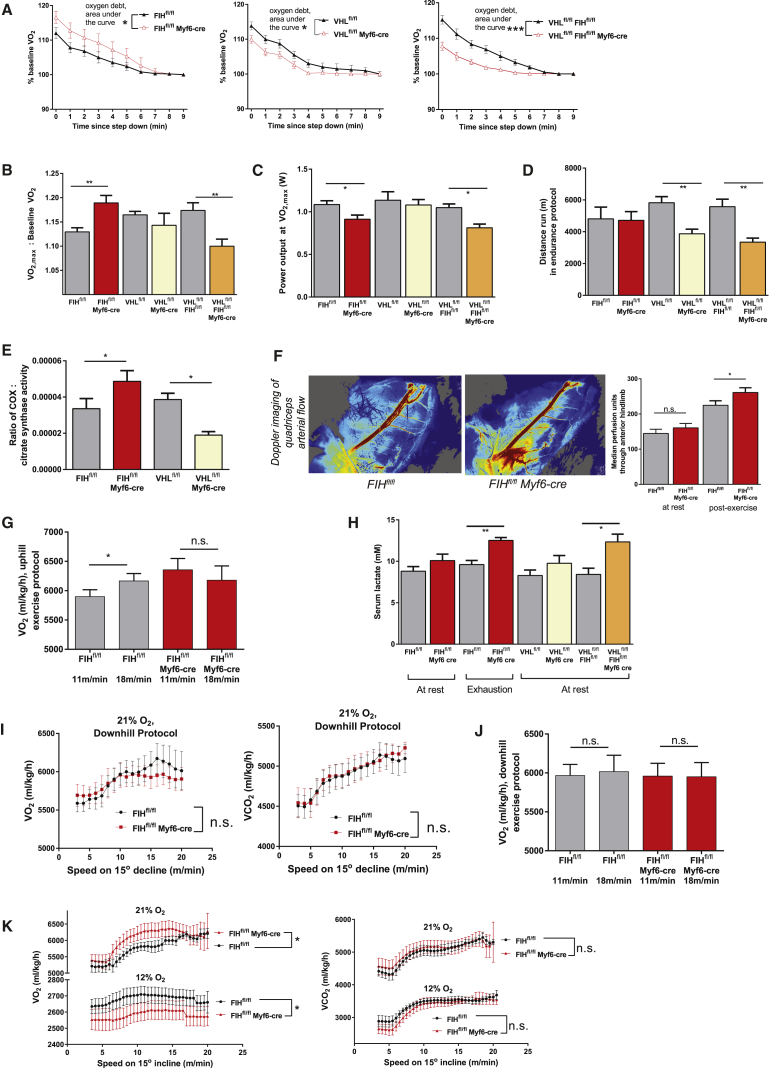
Effects of FIH Loss on Specific Oxidative Parameters in Male Mouse Skeletal Muscle(A) Oxygen debt in male mice of genotypes indicated, following a running protocol of fixed length. n = 5 mice per genotype. After curve-fitting, best-fit equations were compared with an extra sum-of-squares F test.(B) Normalized VO2,max values in male mice of genotypes indicated, following an incremental uphill running protocol.(C) FIH muscle mutant male mice and vHL/FIH double-KO male mice achieve VO2,max at lower exercise intensities compared with controls.(D) Endurance performance on a distance running protocol.(E) Cytochrome oxidase (COX) activity in gastrocnemius muscle lysates from male mice of various genotypes.(F) Local quadriceps perfusion measured by Doppler imaging before and after an uphill running protocol where male mice were run to exhaustion.(G) Changes in VO2 with running intensity within an uphill running protocol.(H) Relationship between blood lactate levels in resting mice and genotype. Blood lactate levels rose more significantly in FIH muscle-specific mutant male mice, following an incremental uphill treadmill protocol where mice were run to exhaustion.(I) Downhill running protocol. Relationships between VO2 and VCO2 measurements and downhill running speed. After curve-fitting, best-fit equations were compared with an extra sum-of-squares F test.(J) Changes in VO2 with running intensity within a downhill running protocol.(K) Relationship between running speed and VO2 or VCO2, when running under 12% oxygen versus under room air. A two-tailed Student's t test was applied to equations of curves fitted separately to control and mutant mice. After curve-fitting, best-fit equations were compared with an extra sum-of-squares F test.∗p < 0.05, ∗∗p < 0.01, ∗∗∗p < 0.001; n.s., not significant. Data are represented as means ± SEM. Only male mice were used for in vivo experiments, with male littermates as controls. n = 7 mice/genotype, unless otherwise stated. For multiple comparisons (B–E), a one-way ANOVA was used. For pairwise comparisons (A, I, and K), a two-tailed Student's t test was used. For grouped data (F–H and J), a two-way ANOVA was used. See also Figure S5.